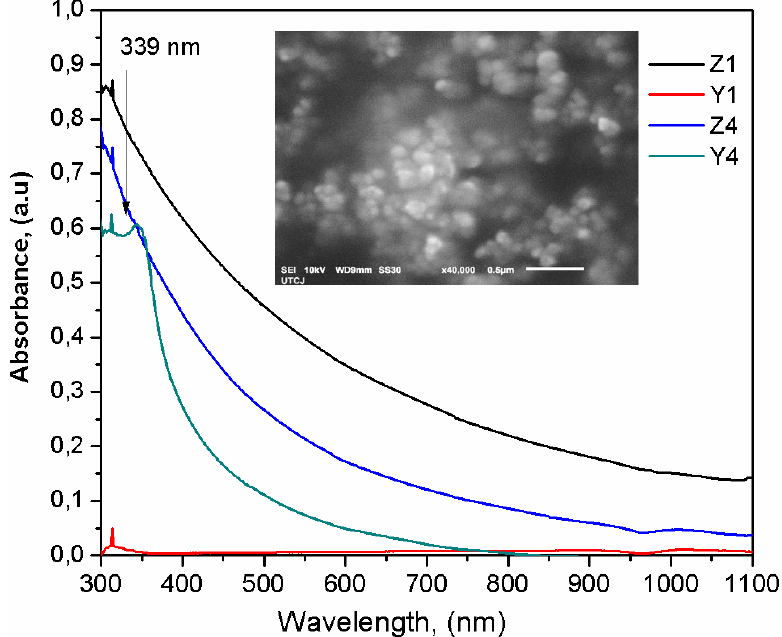
Figure 4. UV-Vis absorbance spectra of ZnO nanoparticles synthesized at different contents, the inset shows a micrograph image for one of the ZnO agglomerates.